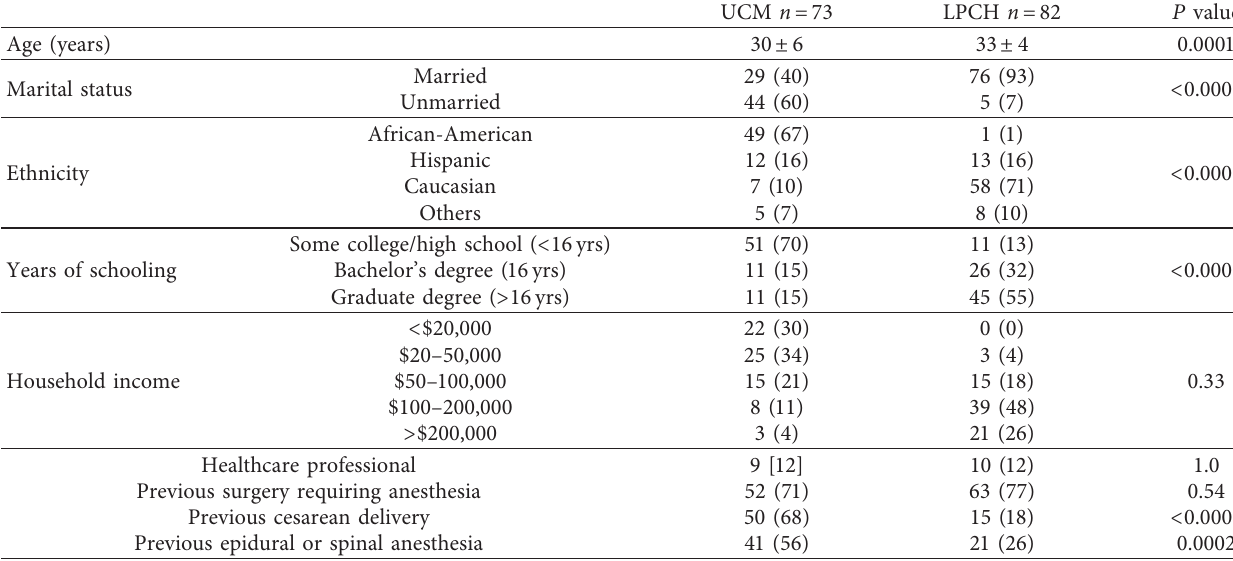
Table 1: Demographic characteristics of respondents from the University of Chicago Medicine compared to those from the previous Lucile Packard Children’s Hospital, Stanford study ∗